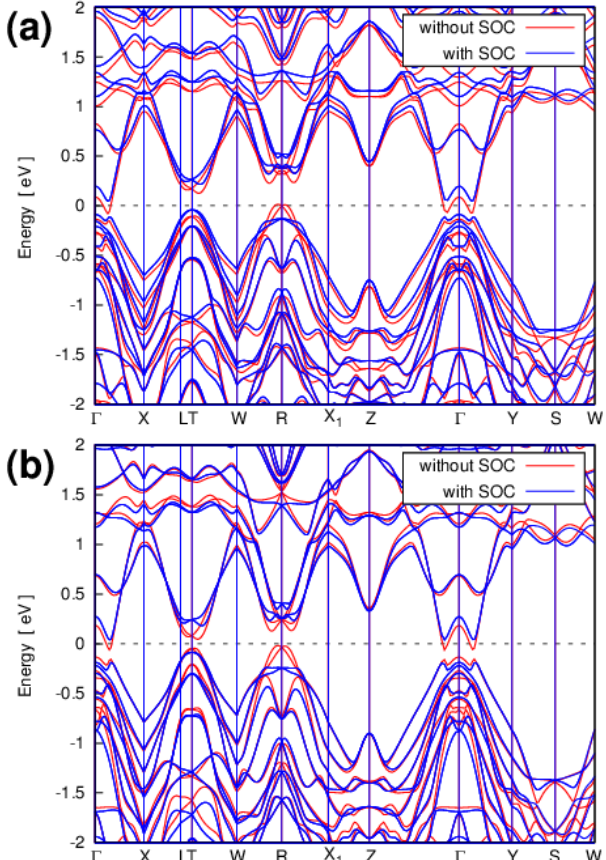
Figure 2. Electronic band structures ( a ) ZrSbTe (Without SOC (red line) and with SOC (blue line)), ( b ) HfSbTe (Without SOC (red line) and with SOC (blue line)).